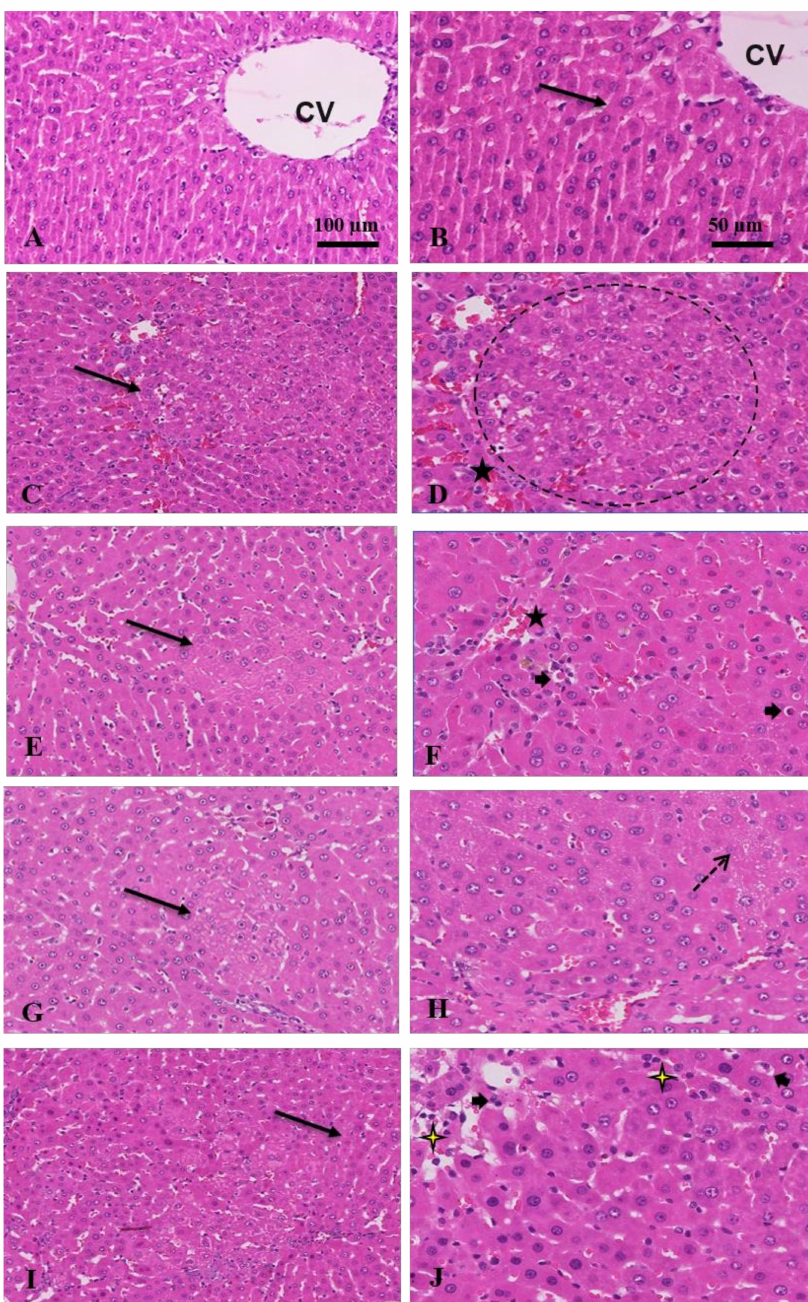
Figure 2. Anti-tumor effect of combination treatment: ( A ) control, untreated shows normal hepa- tocytes; ( B ) intact cell membrane (arrow), and central vein (CV); ( C ) HCC, a moderate increase in cell density (arrow); ( D ) wide distribution of hemorrhage (star) and tumor nodules (circle) with >3 cell strand thickness; ( E ) crocin, eosinophilic cytoplasm with marked reduction in tumor nodules (arrow), cellular density; ( F ) and hemorrhage (star), increase in apoptosis (arrowheads); ( G ) sorafenib, reduced tumor nodules (arrow); ( H ) with marked increased in fat vesicles or steatosis (dot arrow); ( I ) sorafenib and crocin, marked decrease in hyper cellularity, hemorrhage, and steatosis; normal strands thickness (arrow); ( J ) with increased apoptosis (arrowheads) and necrosis (yellow stars) (H&E, × 100 and 50 µ